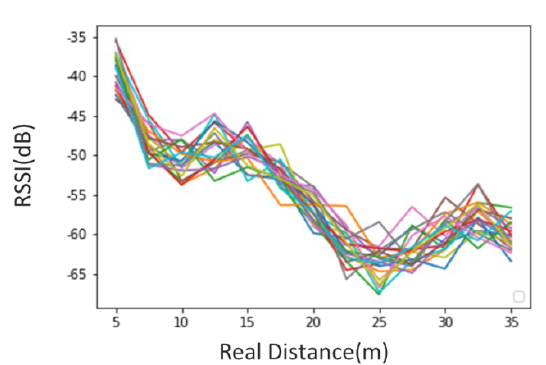
Figure 6. Fifty sets of simulated RSSI decay data over distance of 35 m from AP in Figure 5